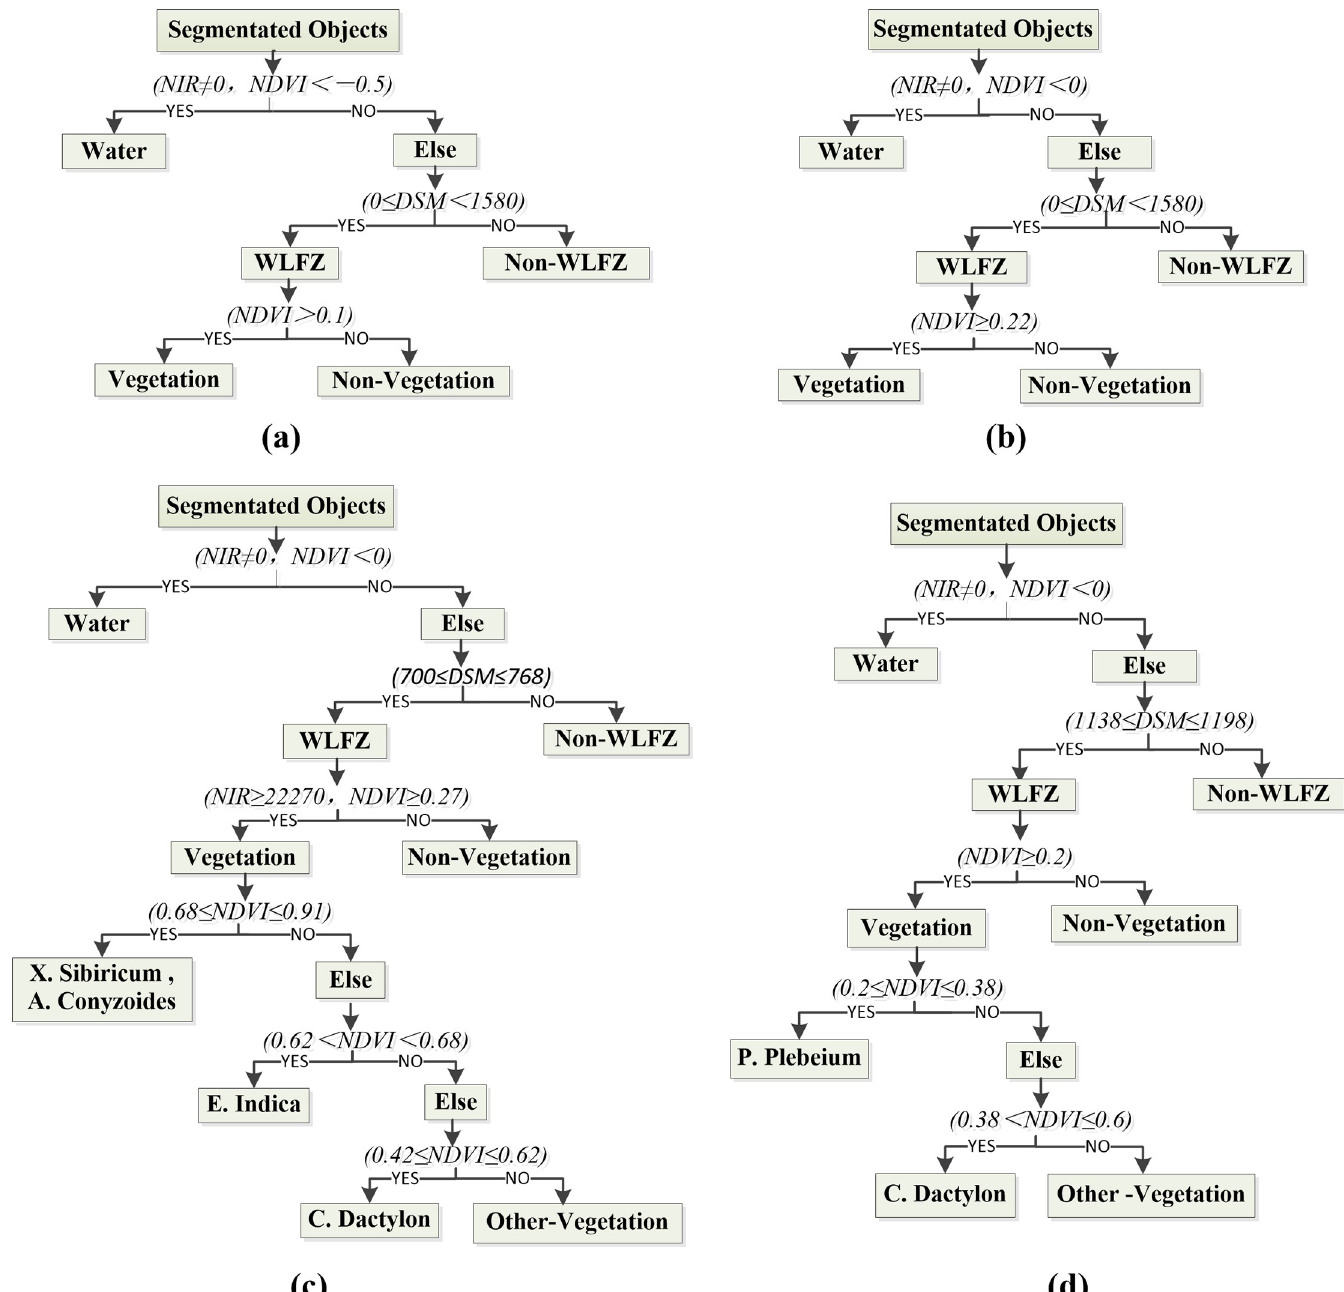
Fig 5. The rule-based classification tree of (a) Huangdeng 1, (b) Huangdeng 2, (c) Nuozhadu and (d) Xiaowan study area.